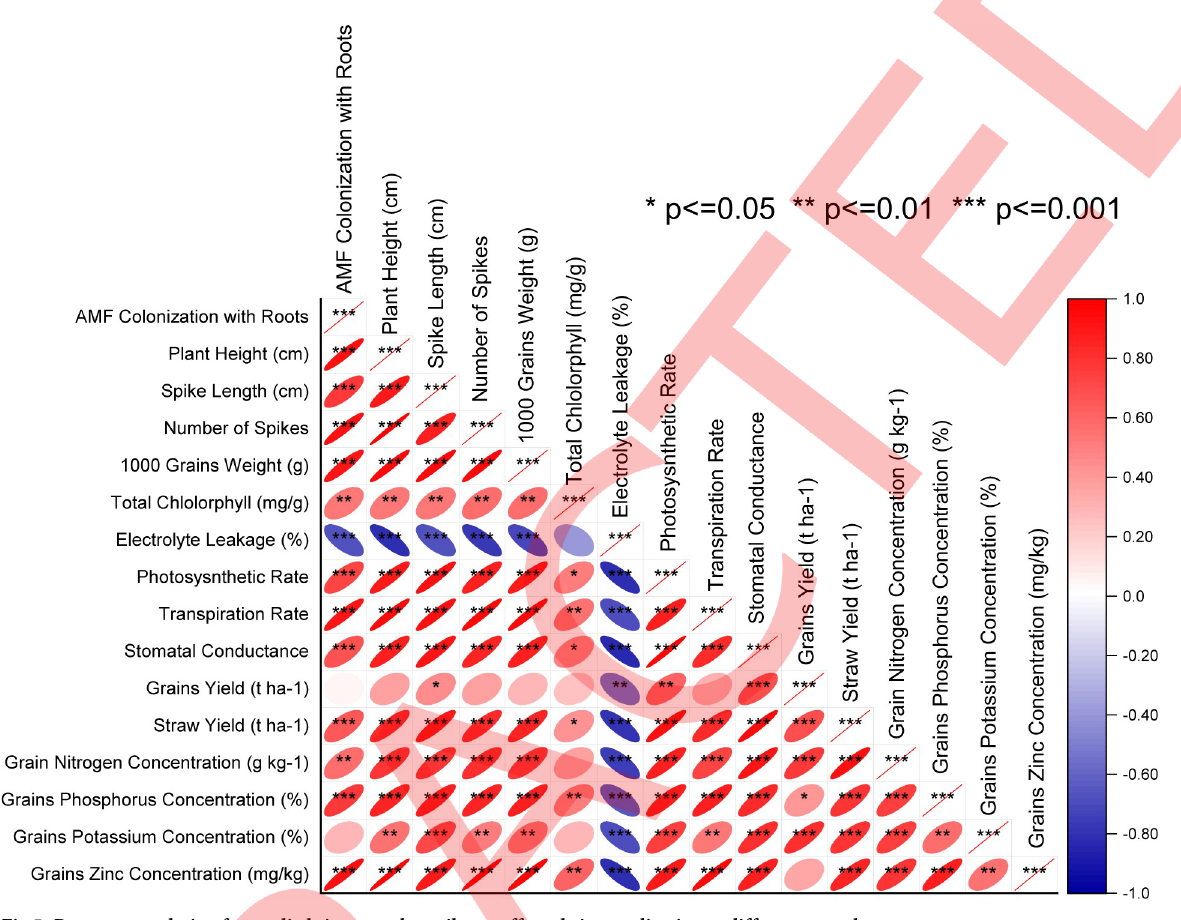
Fig 5. Pearson correlation for studied rice growth attributes affected zinc application at different growth